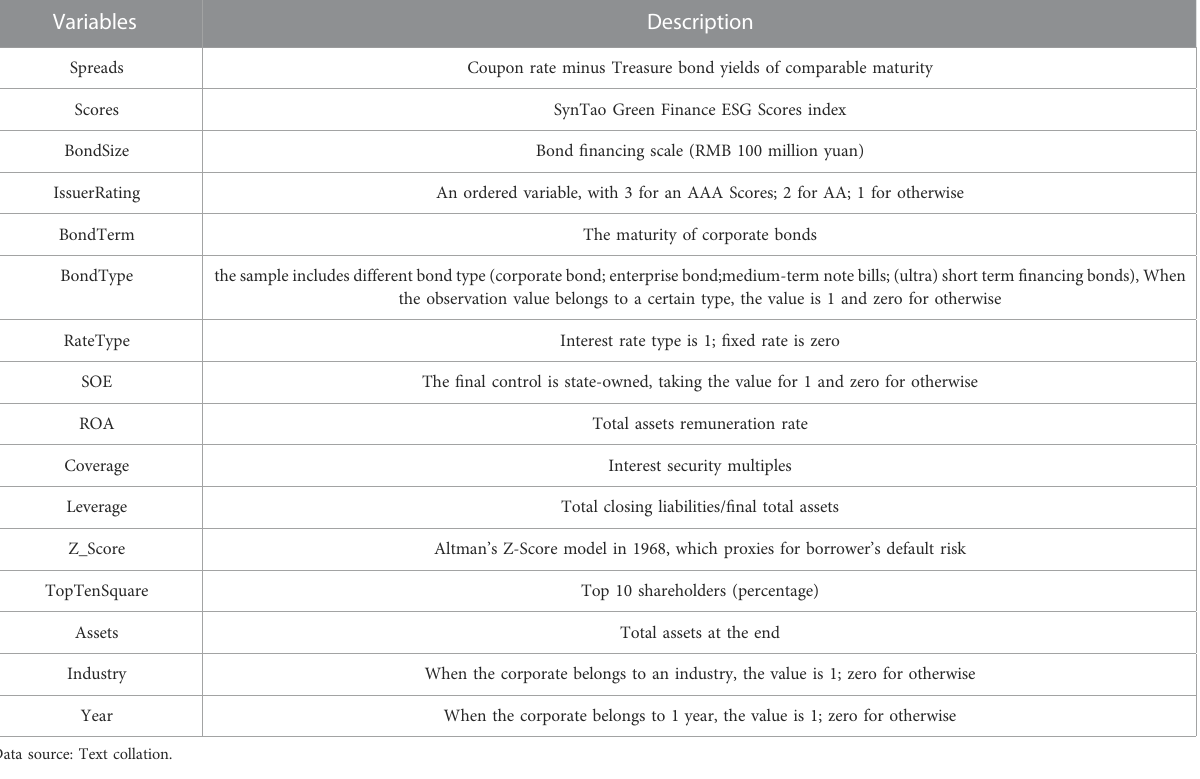
TABLE 1 Variable de fi